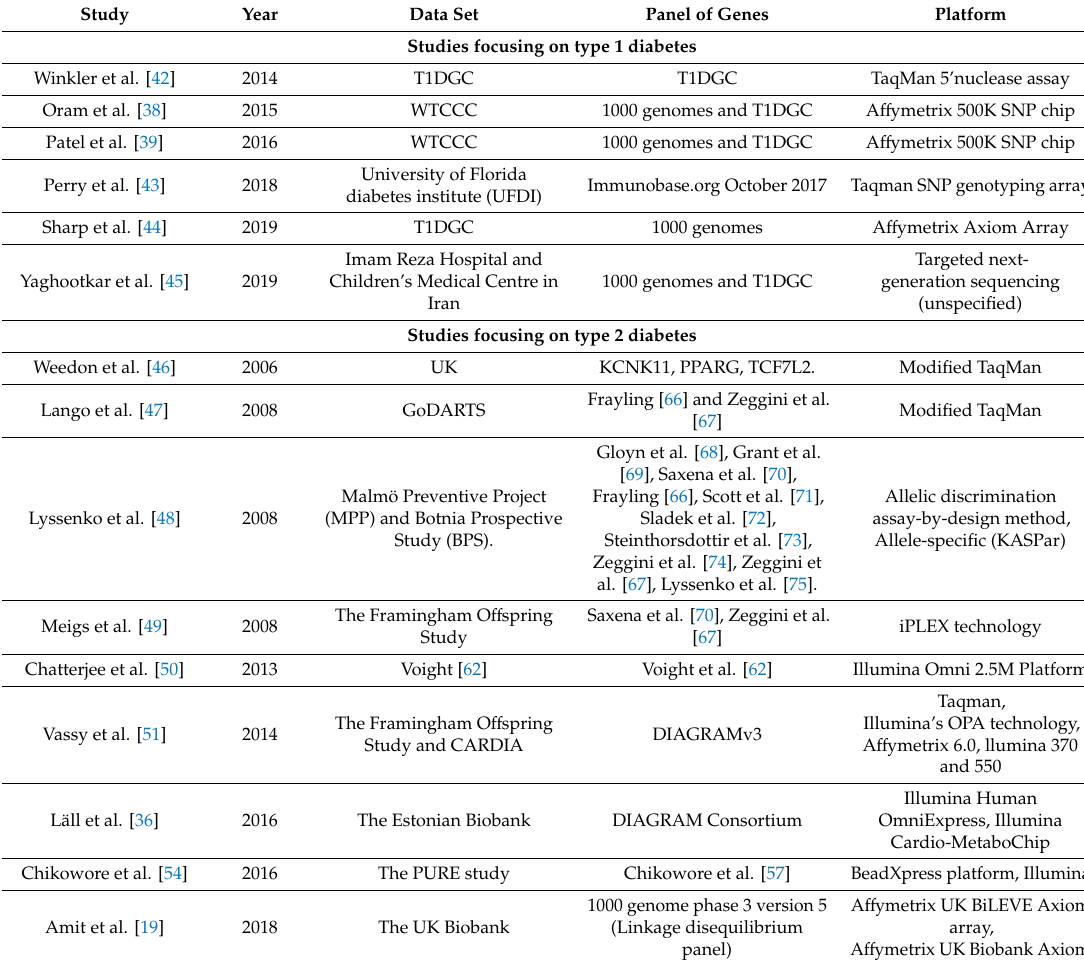
Table 2. Data set source, panel of genes used and genotyping